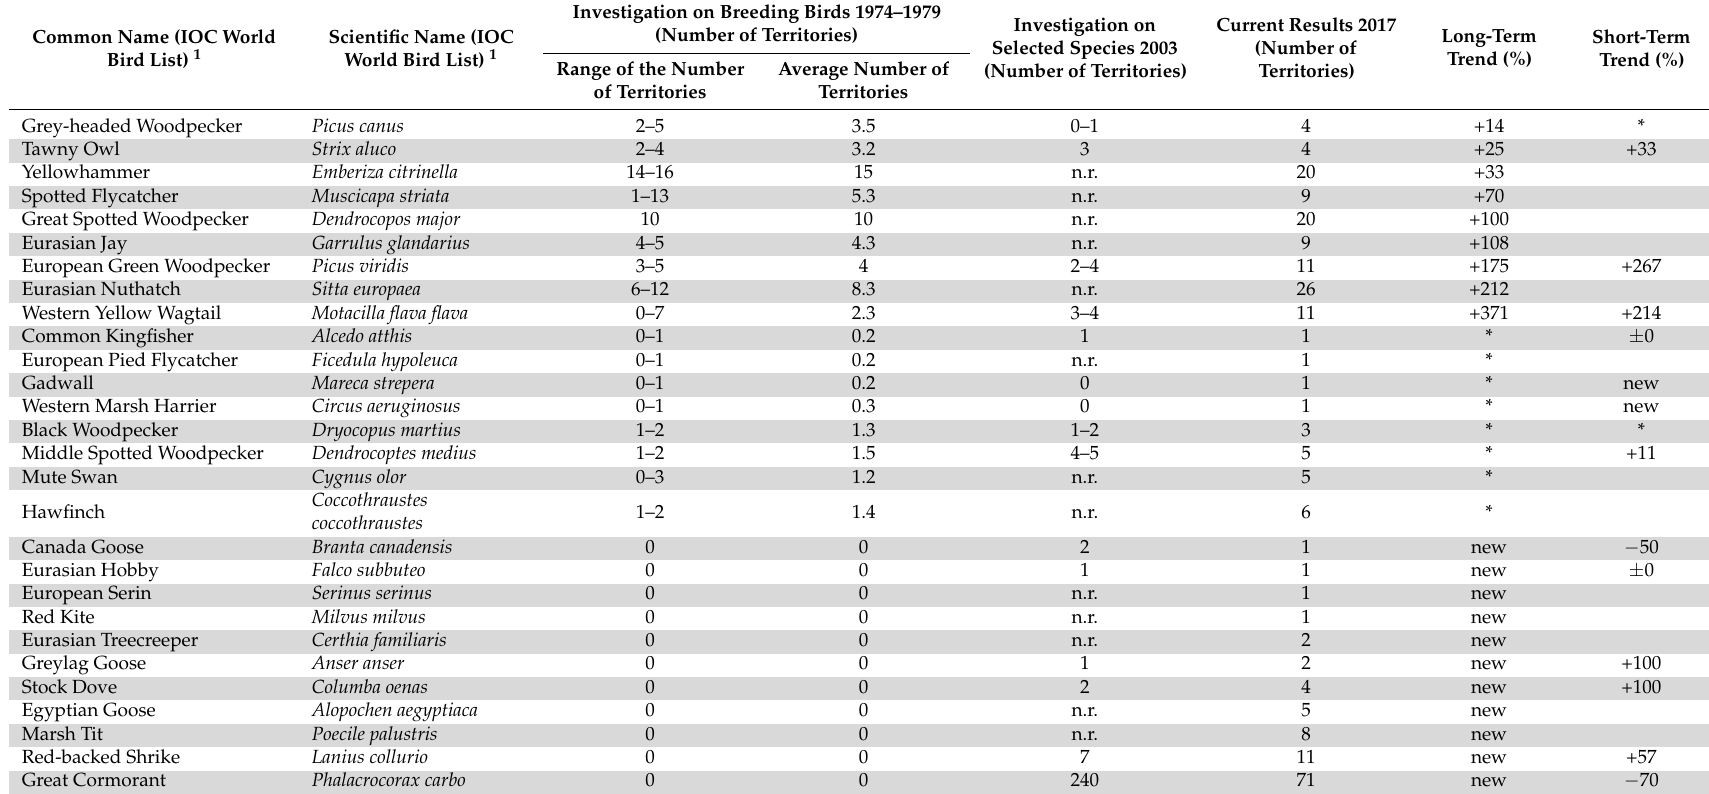
Symbols and Abbreviations: 1 Source: IOC World Bird List Version 7.3 (www.worldbirdnames.org); X former breeding bird species that were not recorded in 2017; ca. results based on sampling areas (1975–1979); new new breeding bird species as compared to the year 2003 or the time period 1974–1979; n.r. species was not recorded in the context of the investigation; * for species with small numbers of territories ( ≤ 2 territories) or irregular breeding occurrence within the time period 1974–1979, increasing numbers of territories led to less meaningful